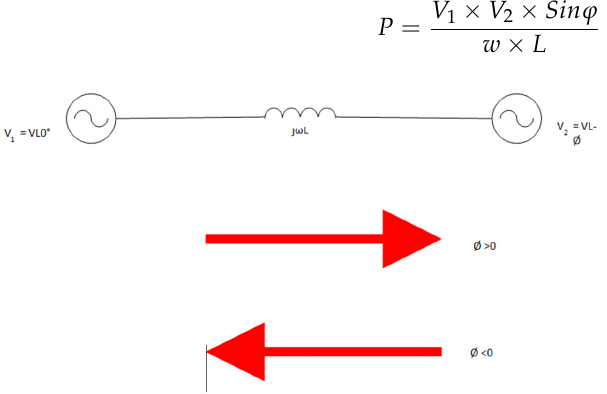
Figure 3. Transfer of power between two voltage buses.